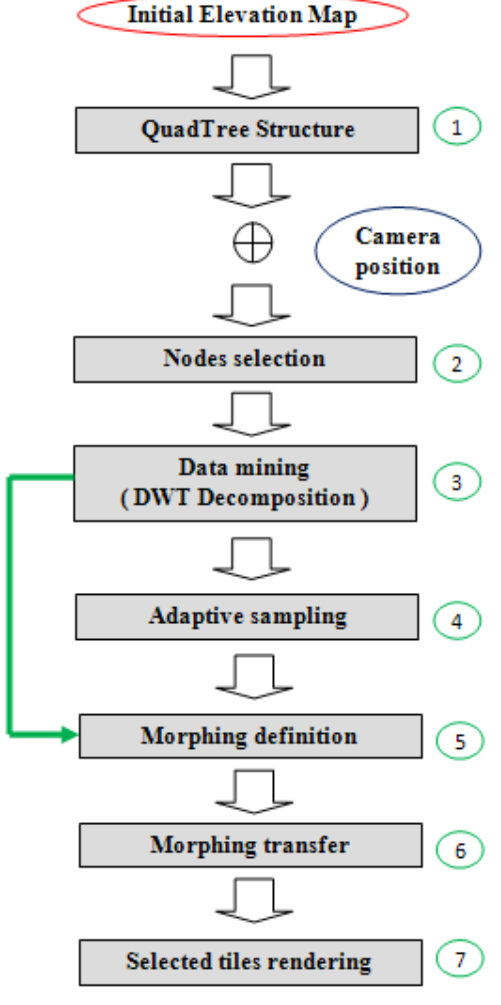
Figure 4. Terrain rendering